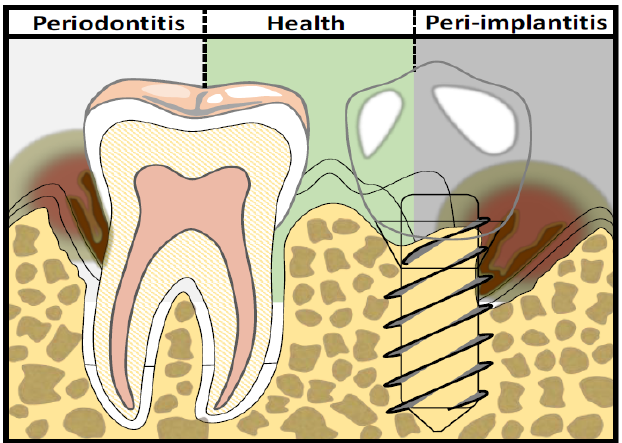
Figure 1. Periodontal health versus periodontitis around natural tooth structure (left); peri-implant health versus peri-implantitis around an implant surface (right).